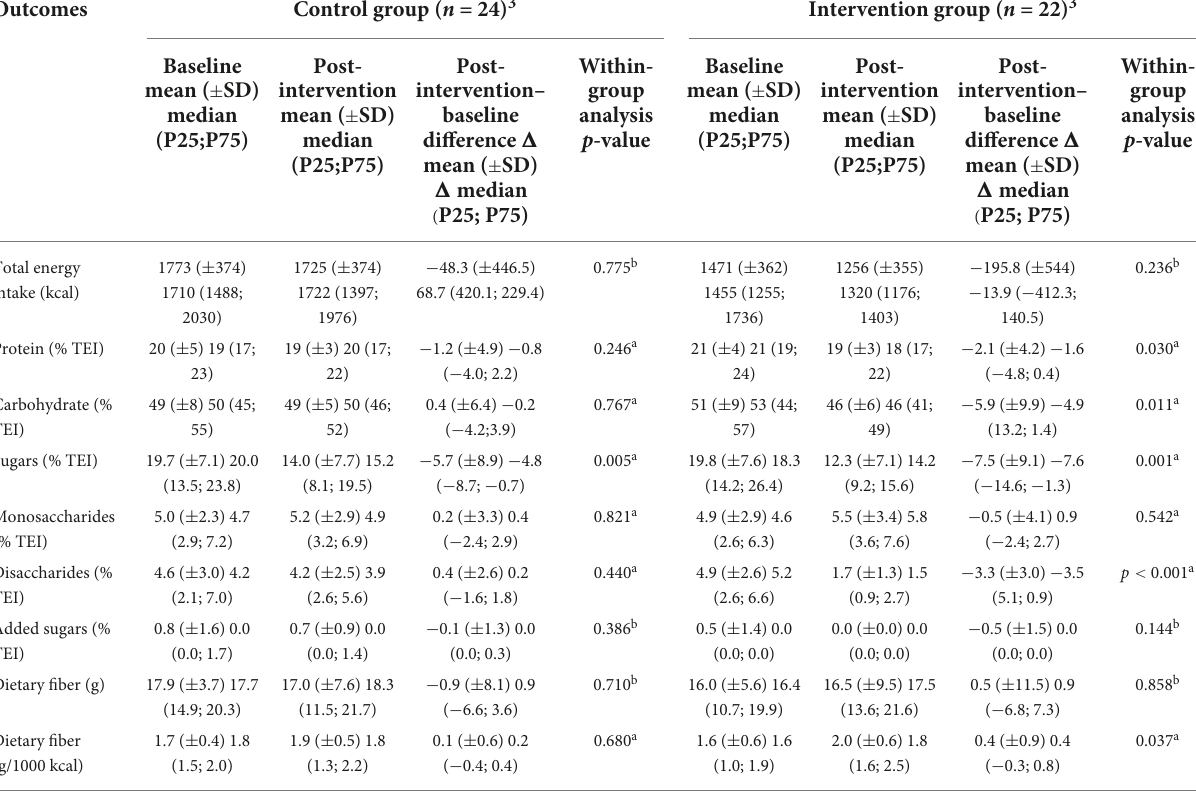
TABLE 2A Dietary intake in control and intervention group at baseline 1 and post-intervention 2